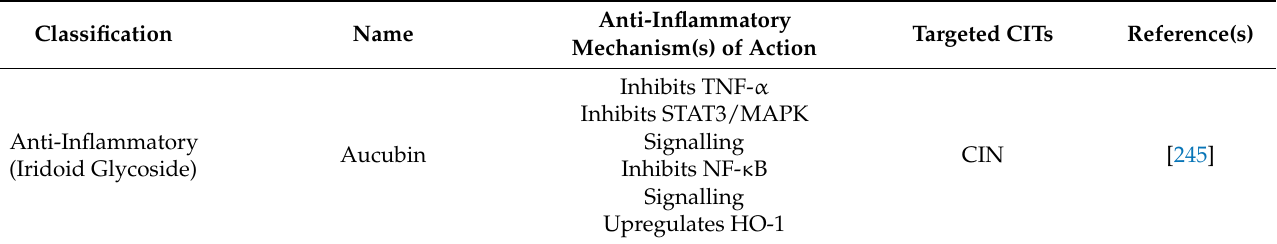
Table 2. Examples of preclinical anti-inflammatory therapeutics for cisplatin-induced